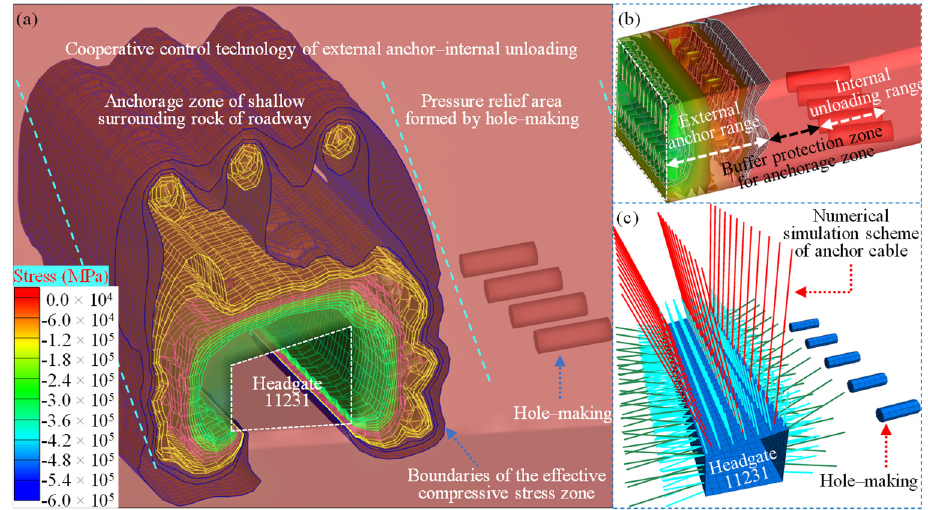
Figure 20. Schematic of the external anchor prestressed field and the hole − making space of coal roadway surrounding rock. ( a ) Three-dimensional prestress field; ( b ) Three zones of roadway rib; ( c ) Anchor bolt (cable) simulation scheme.